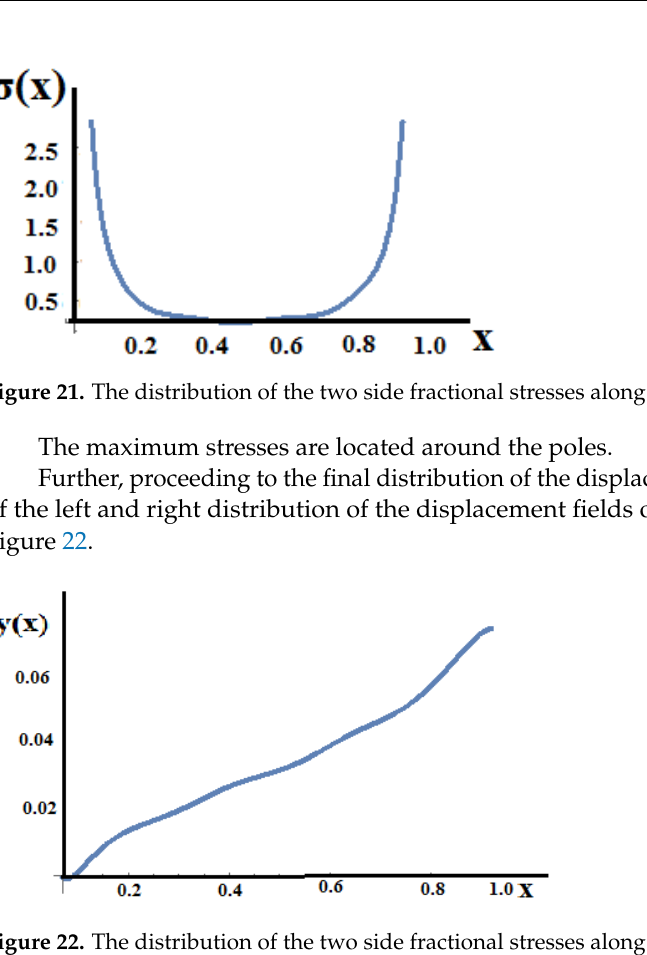
Figure 22. The distribution of the two side fractional stresses along the fractal bar.